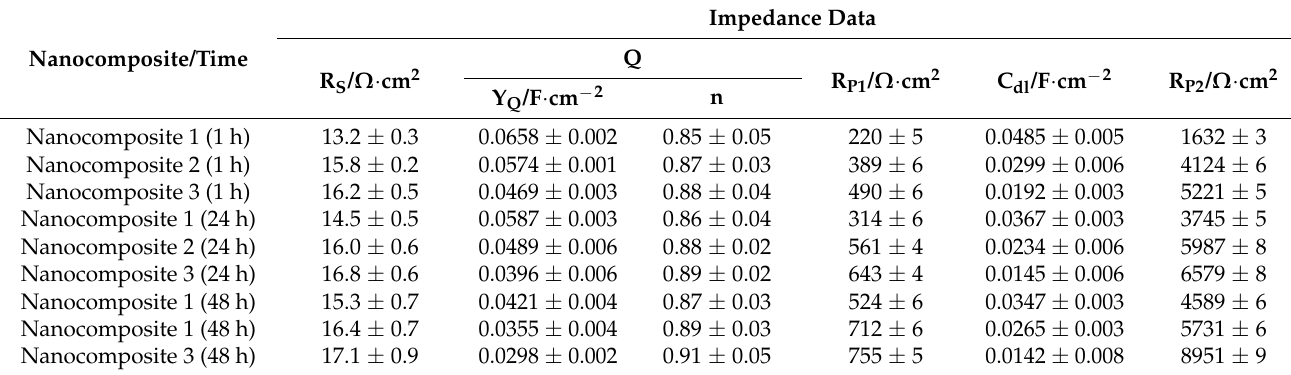
Table 3. Parameters obtained from fitting impedance